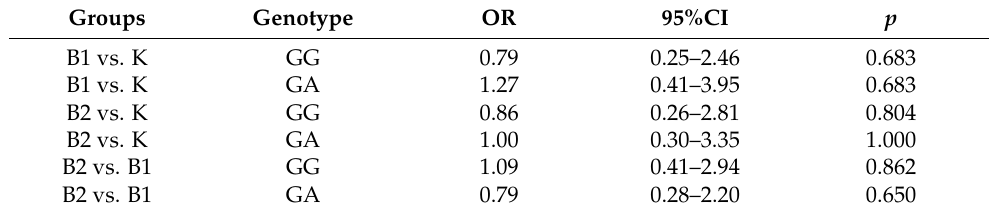
Table 3. Associations between presence of G or A allele of rs17300539 adiponectin gene polymorphism and the likelihood of PCOS with/without concomitant MS; results of logistic regression